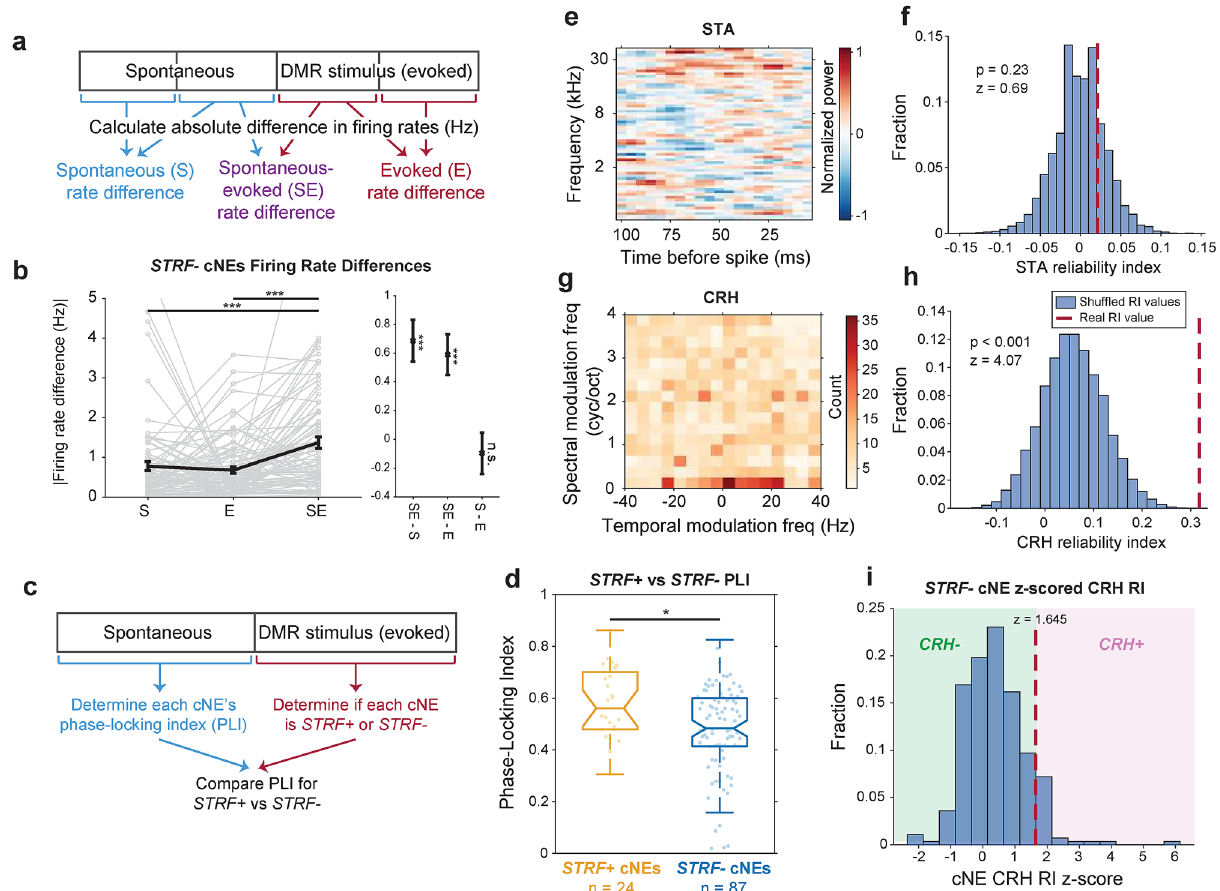
Figure 5. Functional properties of STRF− cNEs. ( a ) Illustration of how rate differences between contiguous spontaneous and evoked epochs were calculated. Both epochs were split into two, and the absolute rate differences between contiguous spontaneous (S) and evoked (E) epochs were compared with the rate differences between contiguous spontaneous and evoked epochs (SE). ( b ) Absolute firing rate differences between spontaneous and evoked (SE) epochs were higher than that of contiguous epochs of the same time (S or E). (left) Raw absolute firing rate differences. (right) Paired differences in absolute firing rate differences. ( c ) Illustration of how phase-locking index (PLI), a proxy for the extent of cNE coupling to UP states, was calculated (also see Supplementary Fig. 5 and “Methods”). ( d ) STRF + cNEs had higher PLIs than STRF− cNEs, suggesting that STRF− cNEs are not trivial results of UP states. ( e – h ) Example STRF− cNE with a significant conditioned response histogram (CRH). ( e ) STA of example STRF− cNE. ( f ) RI of STA for example STRF− cNE. ( g ) CRH of example STRF− cNE. ( h ) RI of CRH for example STRF− cNE. ( i ) Histogram of z-scored CRH RI for STRF− cNEs. STRF− cNEs with a significant CRH only make up about 9% of STRF− cNEs, and cannot explain the